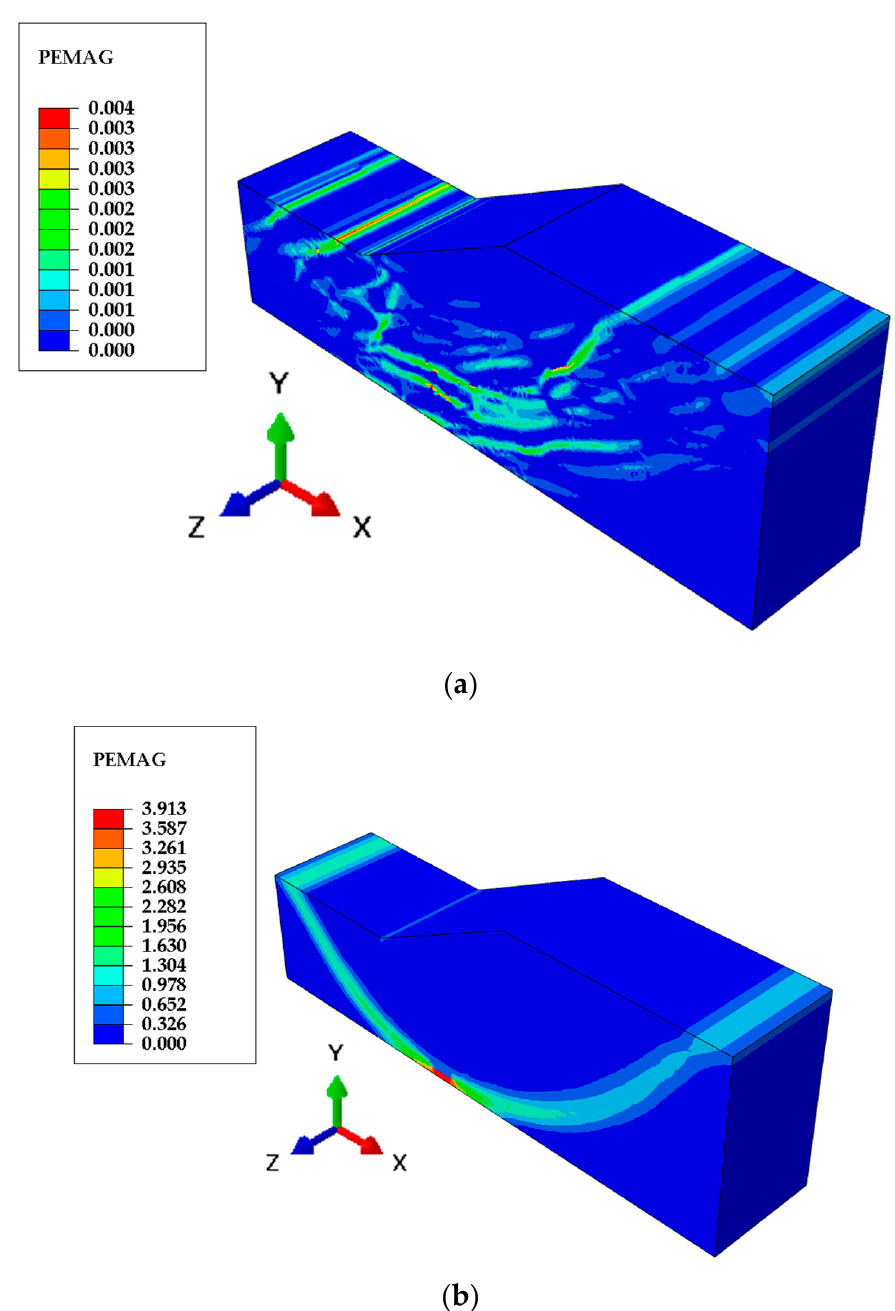
Figure 10. Schematic diagram of typical failure modes of slopes. ( a ) Plastic strain diagram of the slope with weak zones; ( b ) homogeneous slope plastic strain diagram.